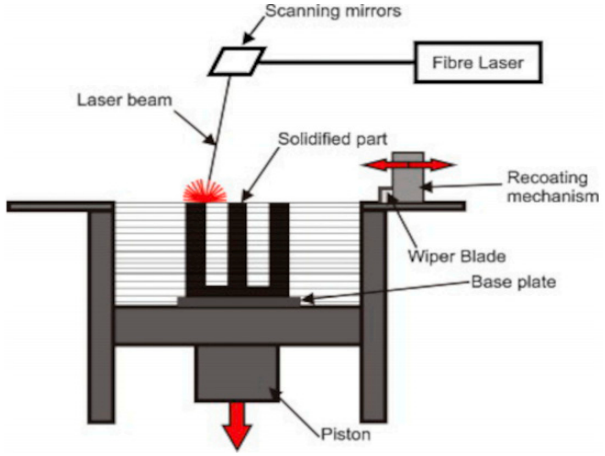
Figure 2. Schematic of the PBF process [17].